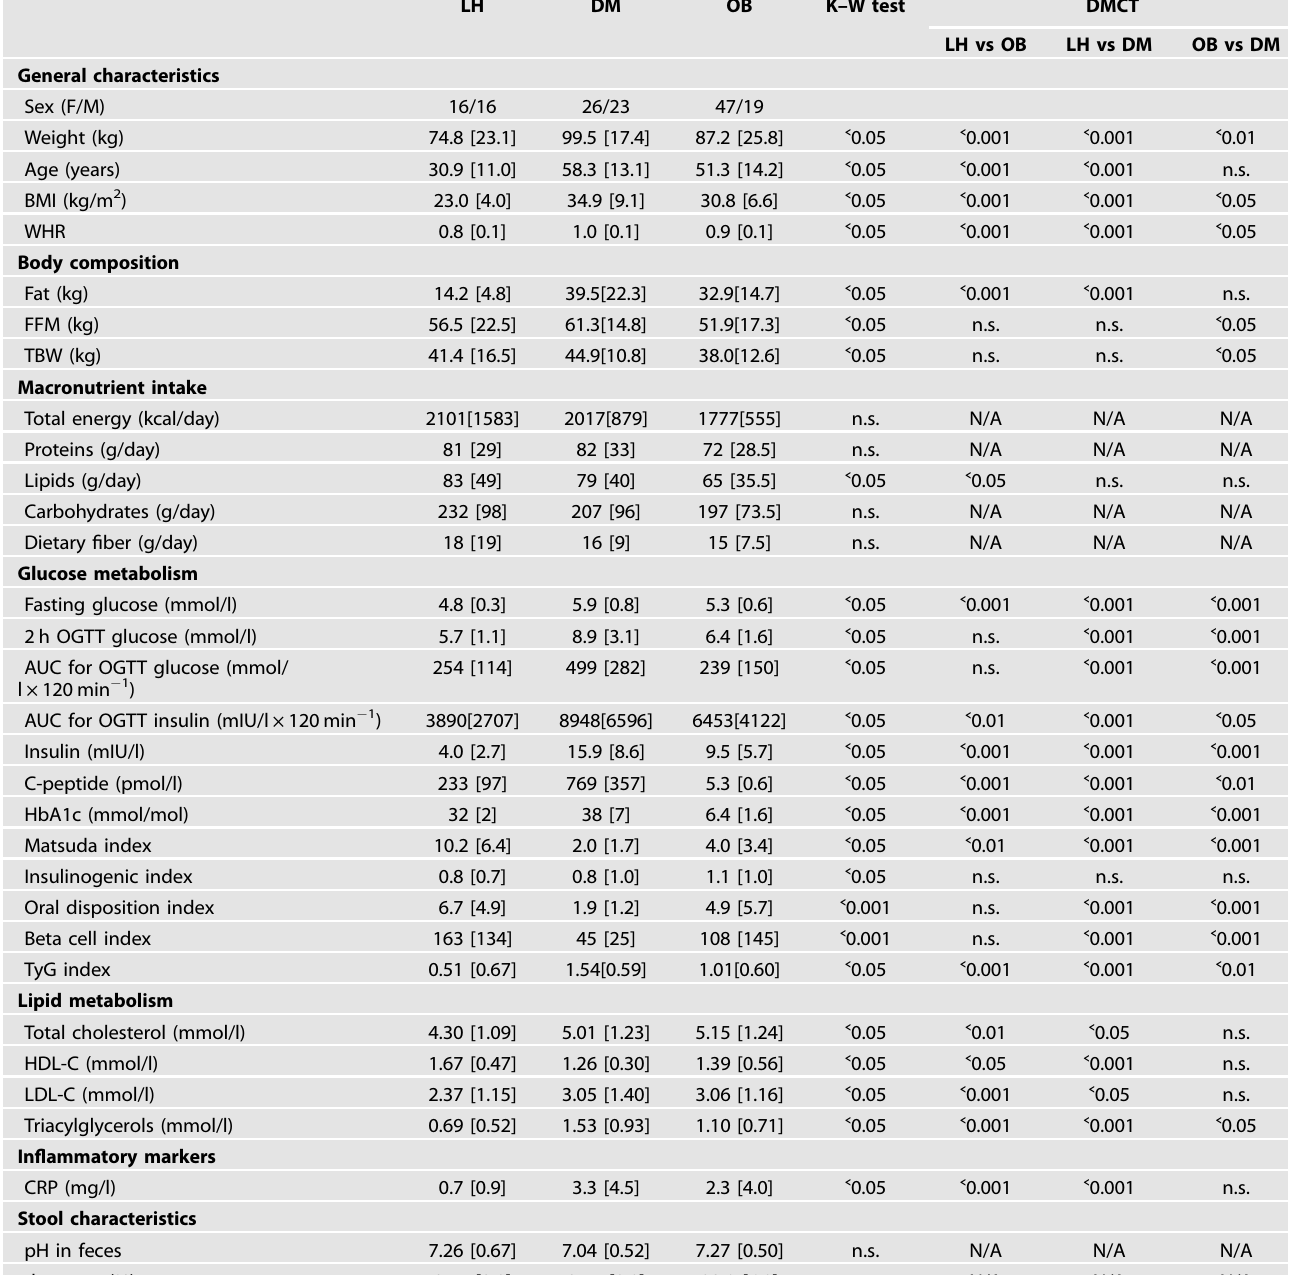
Table 1. Group characteristics for lean (LH), obese (OB) and persons with pre/diabetes (DM). LH DM OB K – W test